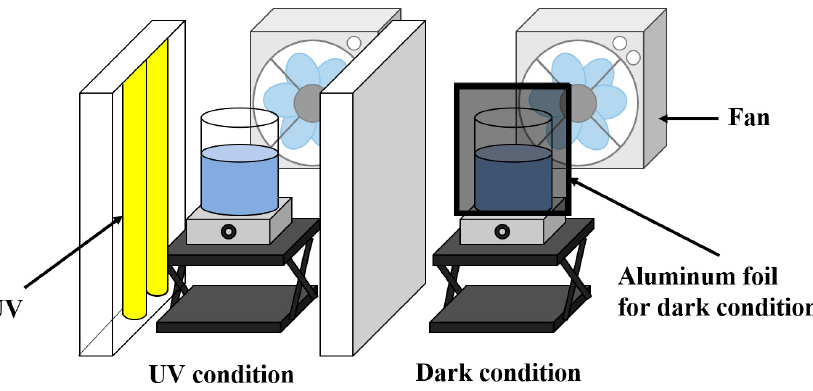
Figure 1. A Schematic of an experimental setup for photocatalytic antibiotics degradation.